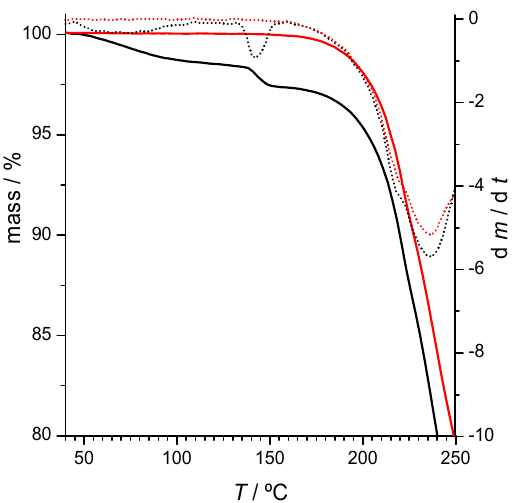
Figure 6. Thermogravimetric (solid lines) and derivative thermogravimetric (dotted lines) curves of x DAP = 0.33 mixtures prepared by ethanol-assisted grinding (black lines) and by neat grinding (red lines), open pans.